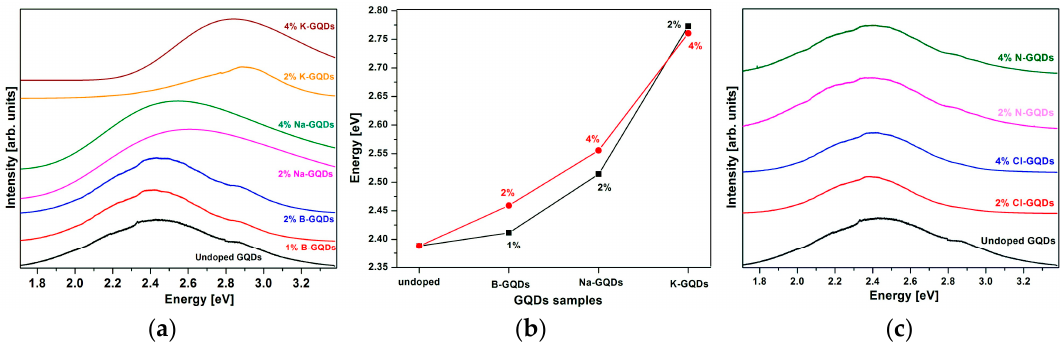
Figure 3. ( a ) Demonstration of blue-shift in photoluminescence (PL) spectra of group A doped GQDs compared to undoped GQDs; ( b ) The change in emission energy as a function of dopant (undoped and group A dopants); ( c ) PL spectra of undoped and group B doped GQDs.